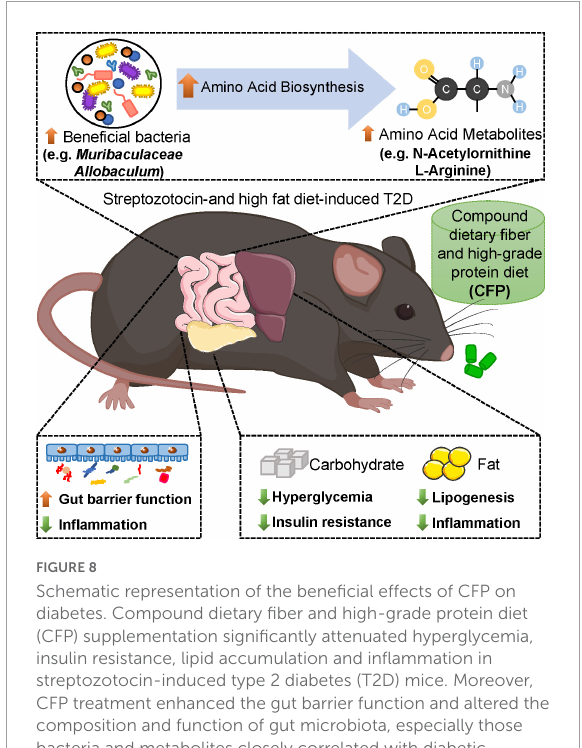
FIGURE8 Schematic representation of the beneficial effects of CFP on diabetes. Compound dietary fiber and high-grade protein diet (CFP) supplementation significantly attenuated hyperglycemia, insulin resistance, lipid accumulation and inflammation in streptozotocin-induced type 2 diabetes (T2D) mice. Moreover, CFP treatment enhanced the gut barrier function and altered the composition and function of gut microbiota, especially those bacteria and metabolites closely correlated with diabetic parameters, and these bacterial functions and metabolites were mainly related to amino acid metabolism. Therefore,